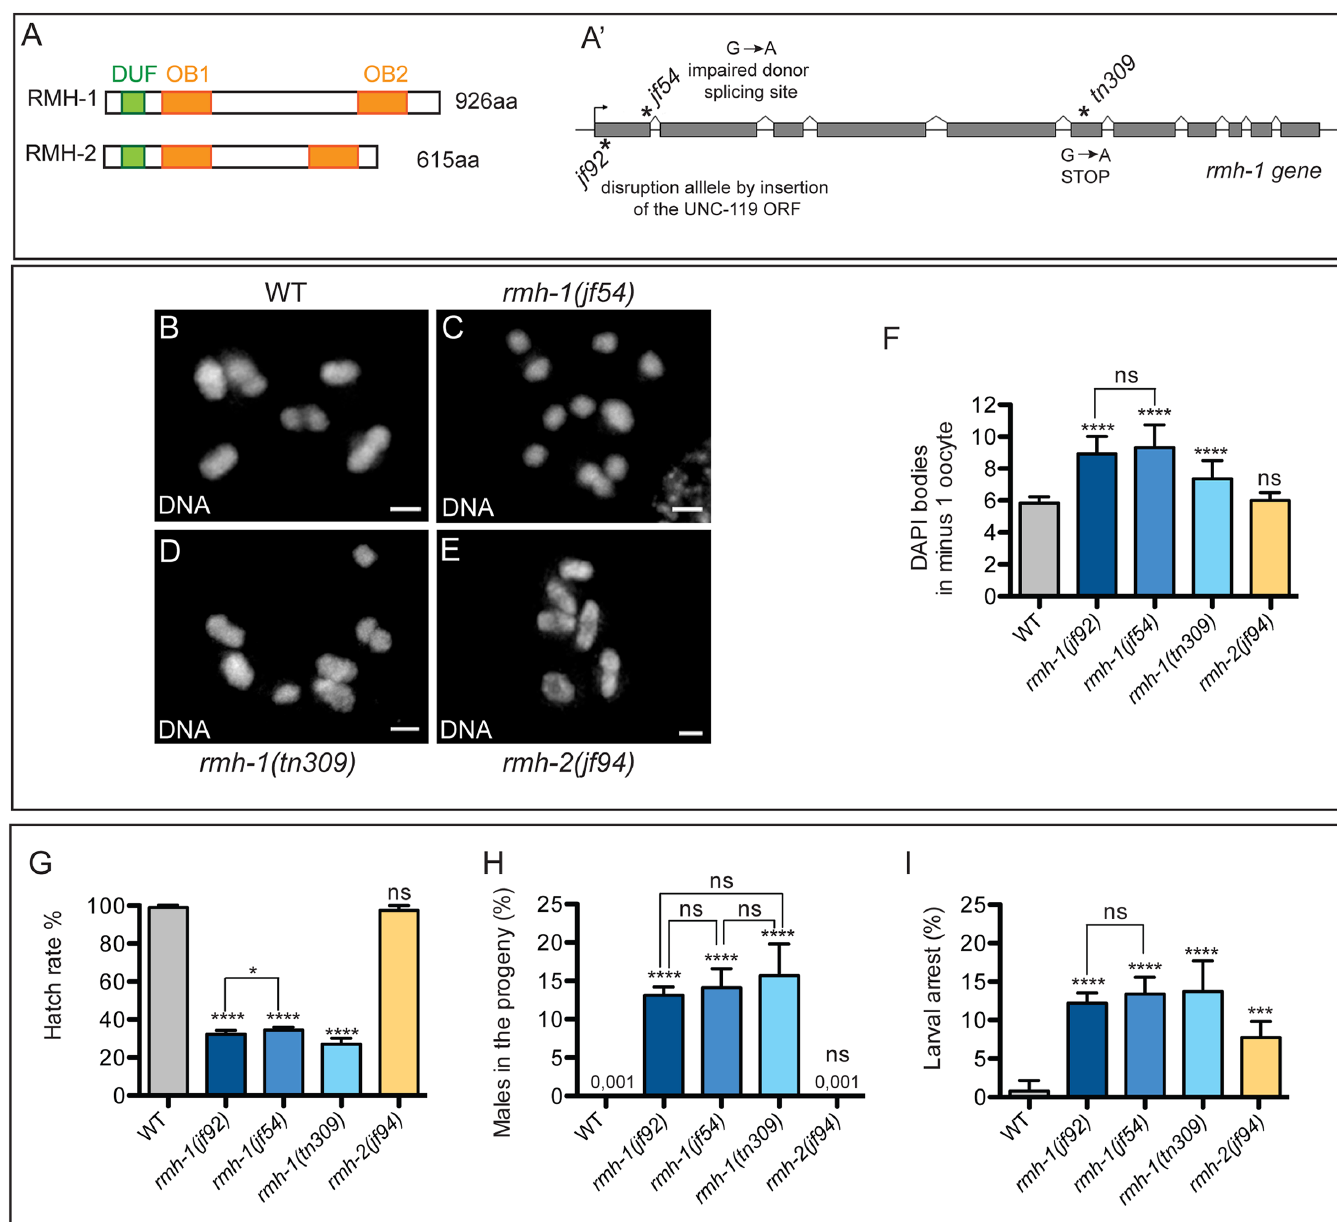
Fig 1. RMH-1 (but not RMH-2) contributes to reliable chiasma formation and chromosome segregation in meiosis. (A) Schematics of RMH-1 and RMH-2. (A 0 ) Location of the three rmh-1 mutations. In the jf92 allele, the coding sequence was disrupted after the START codon by the insertion of the unc- 119 gene by the CRISPR technology. In the jf54 allele, the G-to-A transition affects the first nucleotide of intron 1 and therefore, destroys the splice donor site of the preceding exon 1. qRT-PCR revealed the presence of different splicing variants (see S1 Fig). In the tn309 allele, the G-to-A transition introduces a premature STOP codon at position aa 640, leading to the deletion of the OB2 domain (for more details, see the Experimental Procedures section). (B – E) Oocyte nuclei at the diakinesis stage of meiotic prophase. Each image shows the complete set of DAPI-stained chromosomes from a single nucleus. The wild-type (WT) and rmh-2(jf94) nuclei contain six bivalents (homolog pairs connected by chiasmata), whereas the rmh-1 mutant nuclei contain a mixture of bivalents and univalents. (F) Quantification of the average number of DAPI-positive structures in diakinesis oocytes in the -1 position. WT n = 25, rmh-1(jf92) n = 21, rmh-1(jf54) n = 36, rmh-1(tn309) n = 30, and rmh-2(jf94) n = 18. (G – I) Quantification of embryonic hatch rates (G). Frequencies of male offspring (H) and larval arrest (I) among the progeny of WT and rmh-1 and rmh-2 mutant worms ( n = 35 – 45 hermaphrodites per genotype). Data for F – I are represented as mean +/- SD; ns stands for not significant, differences are highlighted with stars ( * p < 0.05, ** p < 0.01, *** p < 0.001. and **** p < 0.0001). Scale bars, 2 μ m.